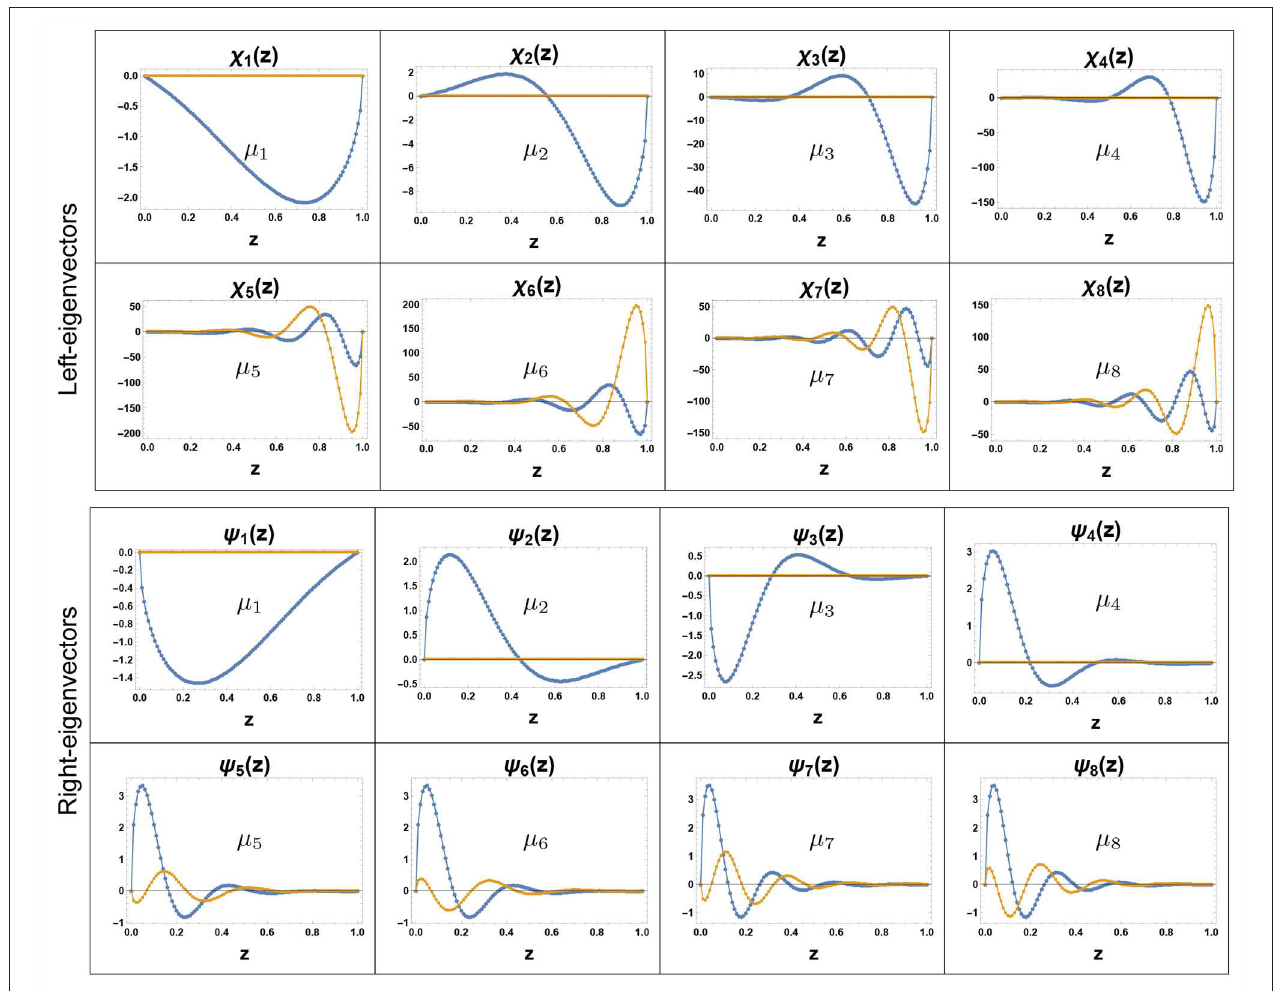
1,2,3,4,5,6,7,8. The real parts are indicated by blue lines while orange denotes the = 1,2,3,4) are also real where the eigenvectors corresponding to complex =